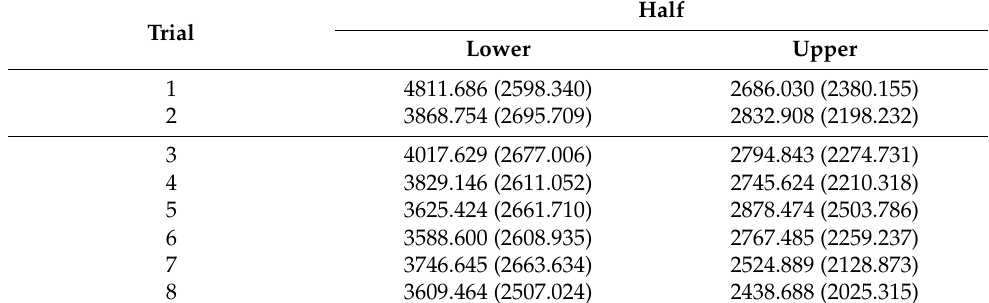
Table 2. Mean looking on each trial (SD) in ms to the lower and upper halves of the faces averaged across infants.